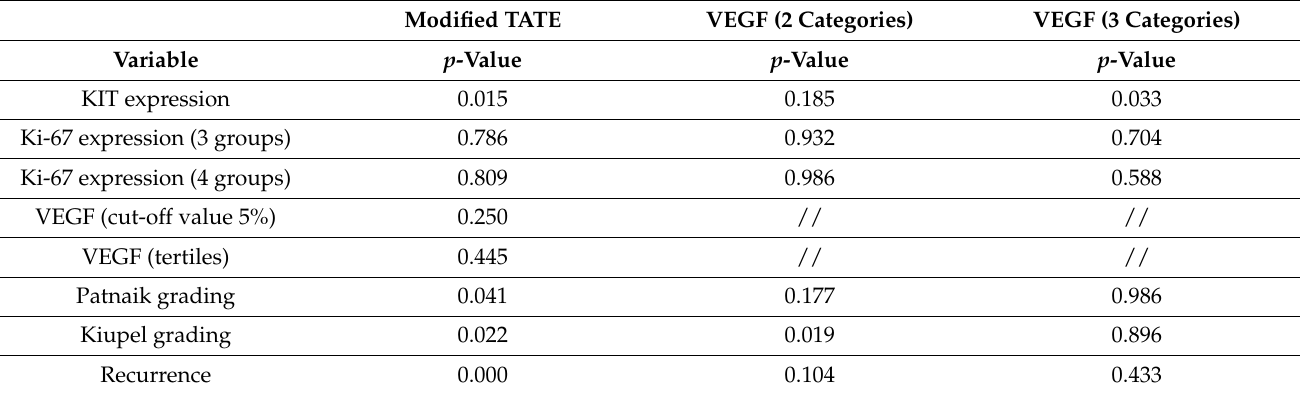
Table 3. Association between immunohistochemical markers, histological grading, recurrence, VEGF expression, and modified TATE. VEGF (2 Categories)